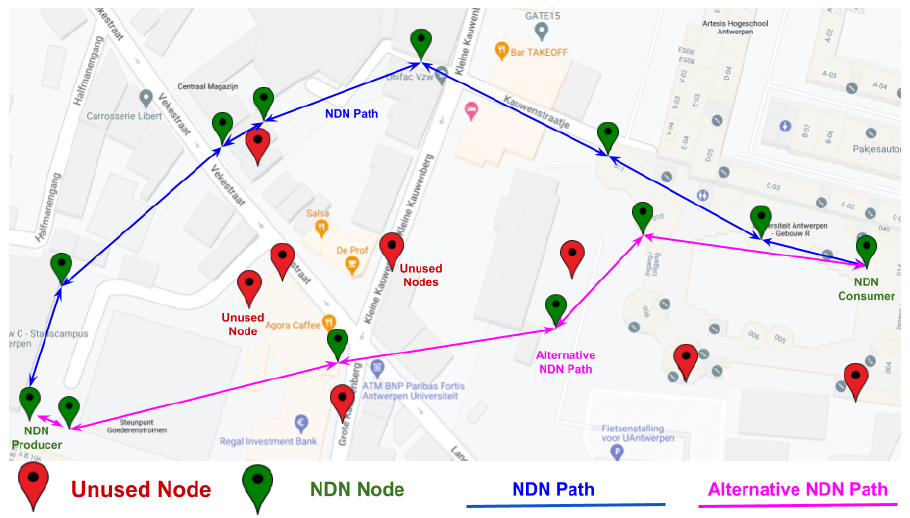
Figure 1. Example of NDN communication over CityLab testbed